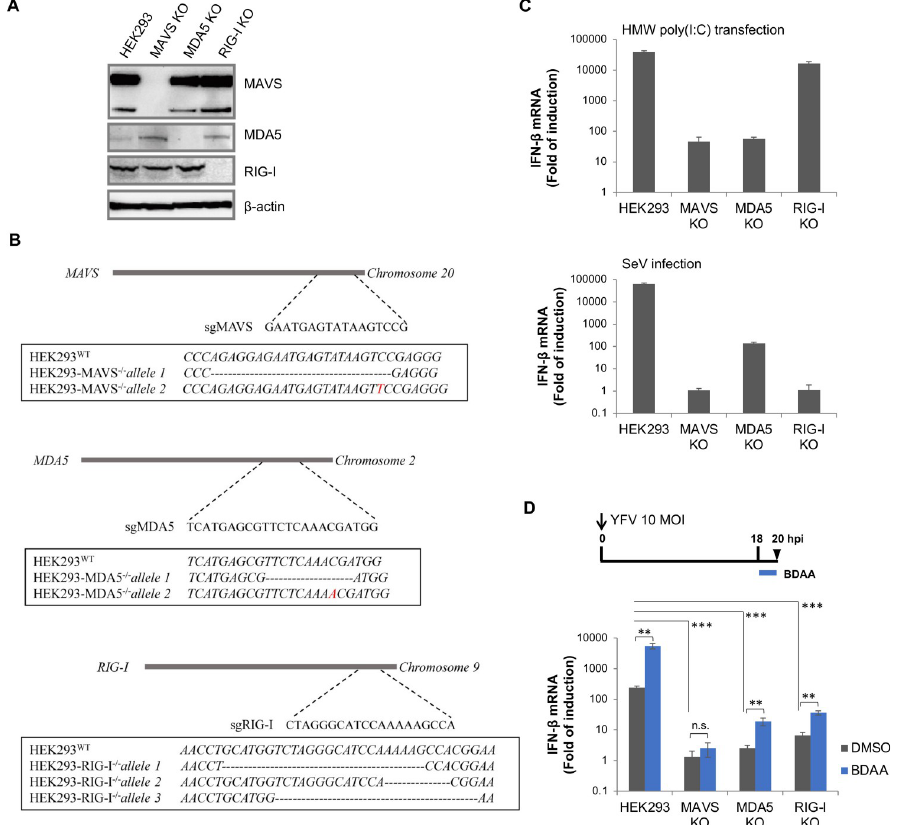
Fig 7. Characterization of HEK293 cells with RIG-I, MDA5 or MAVS knockout. (A) Expression of RIG-I, MDA5 or MAVS in wildtype and knockout cell lines were detected by western blot assay, using β -actin as a loading